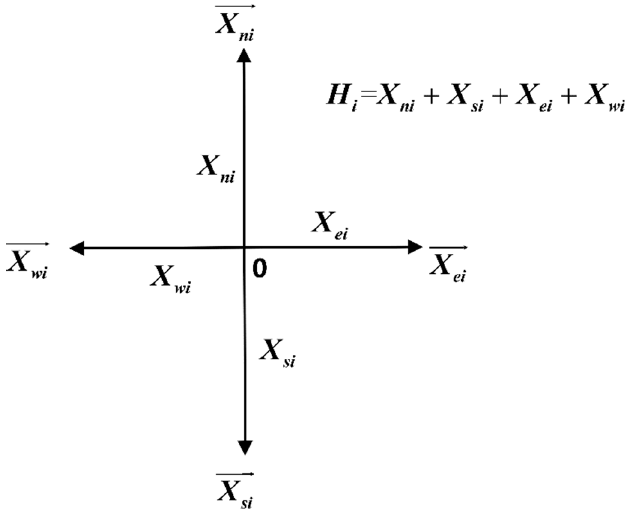
Figure 3. Variable definition diagram.